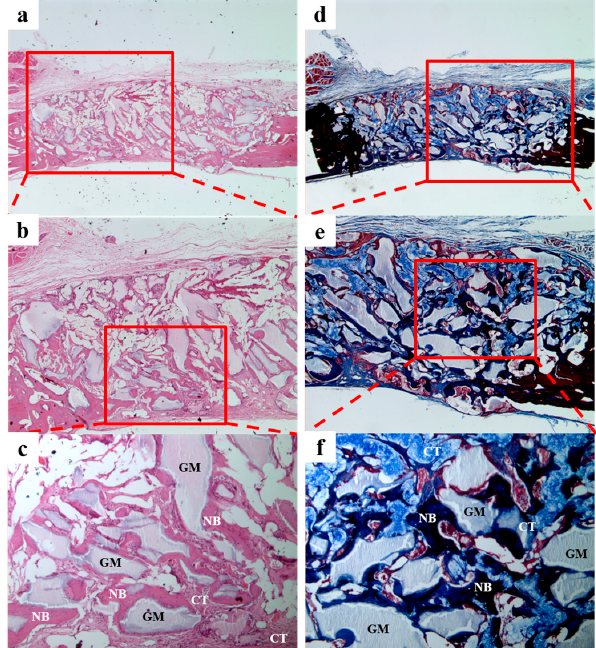
Figure 12. Histological sections of the BCP/c-CMC group at four weeks after surgery. A great amount of new bone formation and a small amount of fibrous connective tissue were observed. NB, new bone; GM, grafted material; CT, connective tissue. H&E stain results ( a – c ); and Masson’s trichrome stain results ( d – f ) (original magnification: ×20 ( a , d ); ×40 ( b , e ); and ×100 ( c , f )).